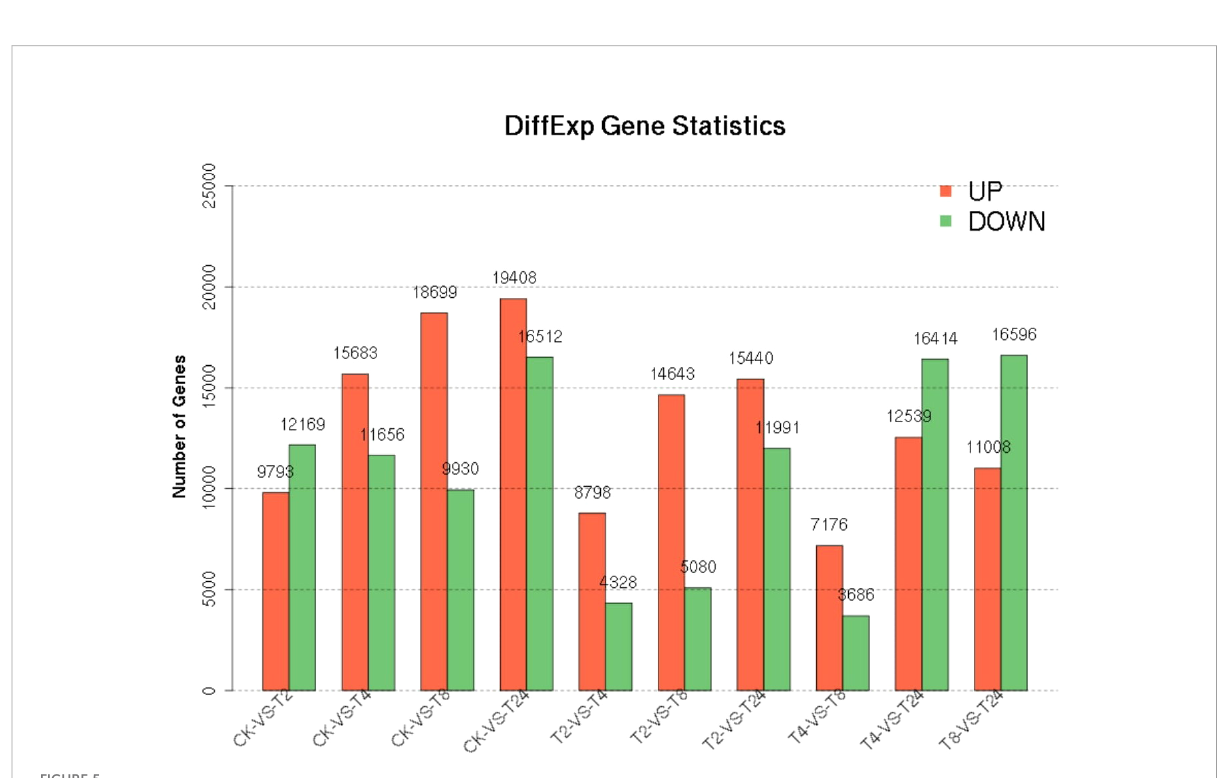
FIGURE 5 Statistics of differential genes between